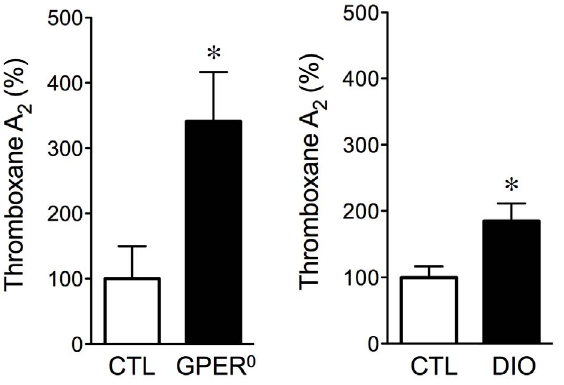
Figure 6. Production of thromboxane A 2 by perivascular adipose. Thromboxane A 2 release was stimulated during serotonin- dependent contractions and measured as its hydrolyzed metabolite thromboxane B 2 . Measurements in vascular rings without perivascular adipose were subtracted from rings with perivascular adipose and normalized to dry weight to reveal functional changes in perivascular adipose. Measurements were performed in perivascular adipose from mice with monogenic obesity (GPER 0 , left panel, solid bar, n =4) or from mice with diet-induced obesity (DIO, right panel, solid bar, n =5). Age- matched WT mice fed a regular chow served as controls (CTL, open bars, n =6, mean thromboxane A 2 production: 15.1 6 3.8 pg/mg). * p , 0.05 vs.